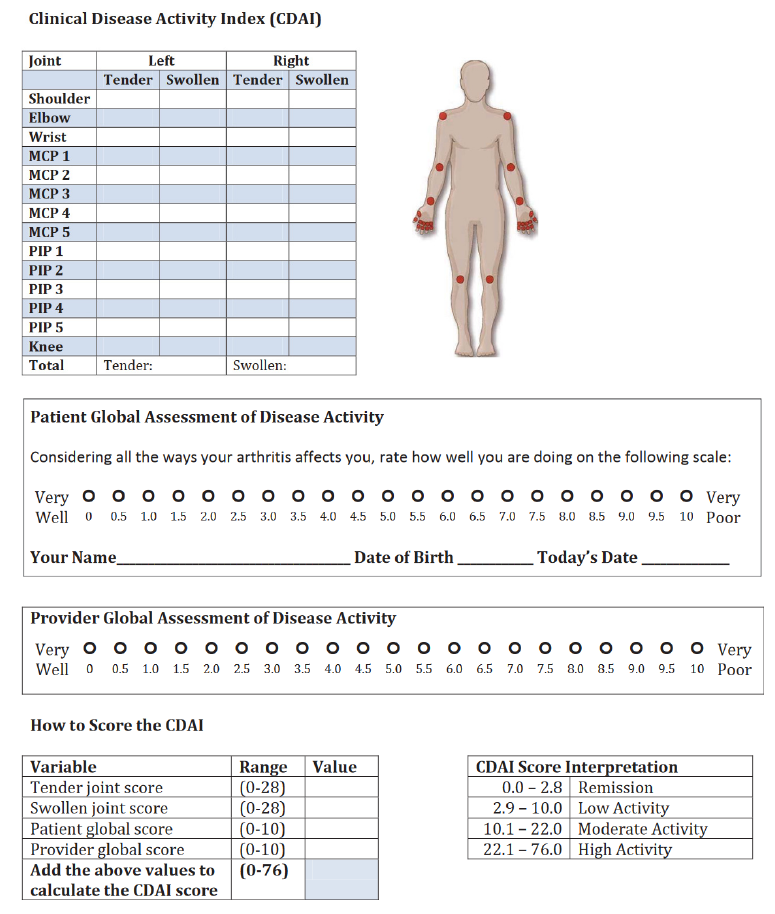
Figure 8. Typical CDAI activity index template.